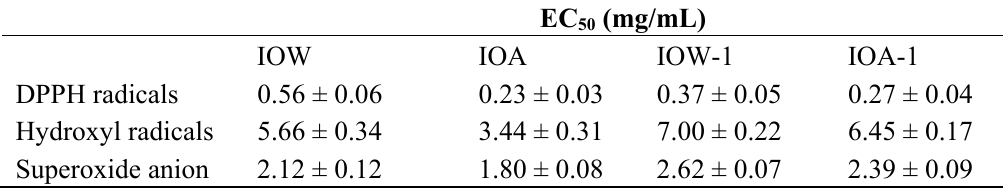
values of the extracts from I. obliquus in radical scavenging Table 2. EC 50